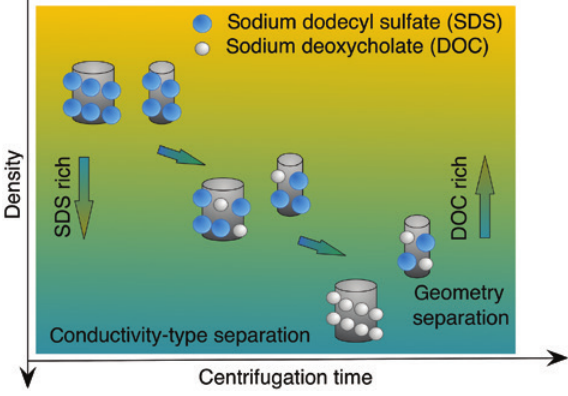
Figure 4: CNT separation using two different